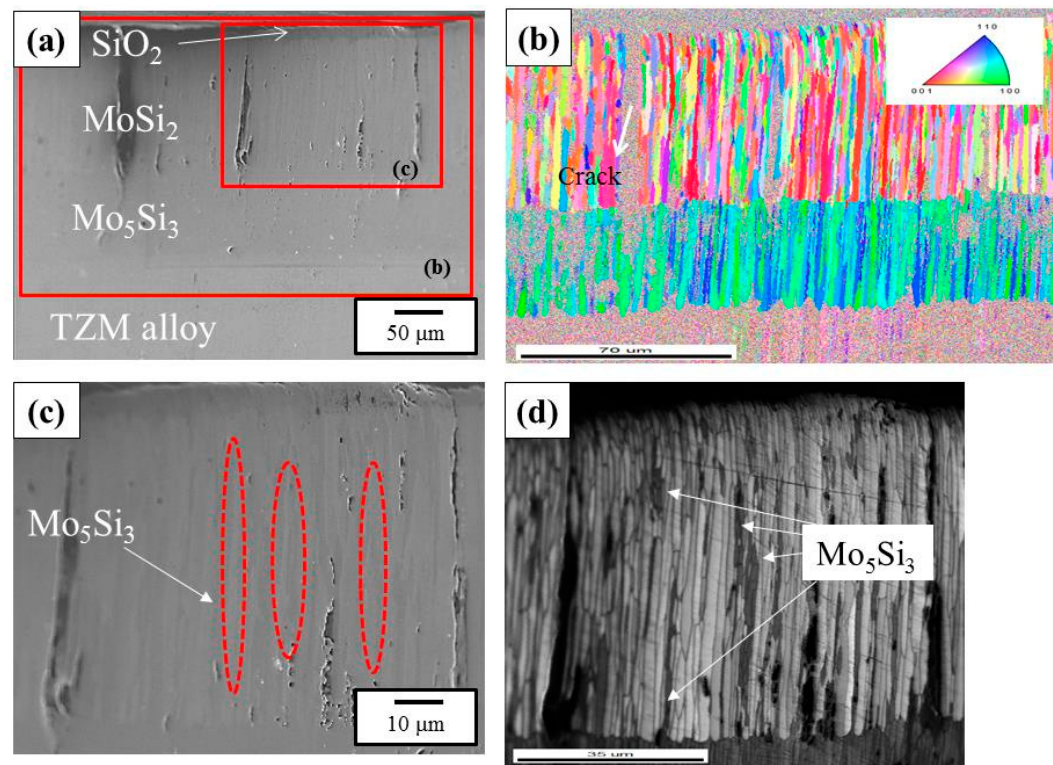
Figure 6. Cross-sectional SEM of the MoSi 2 -coated TZM alloy oxidized at 1350 °C for 20 h. ( a ) SEM; ( b ) EBSD micrograph of the large area marked in ( a ); ( c ) the enlargement of the small inset in ( a ); and ( d ) image with black and white contrast of ( c ).